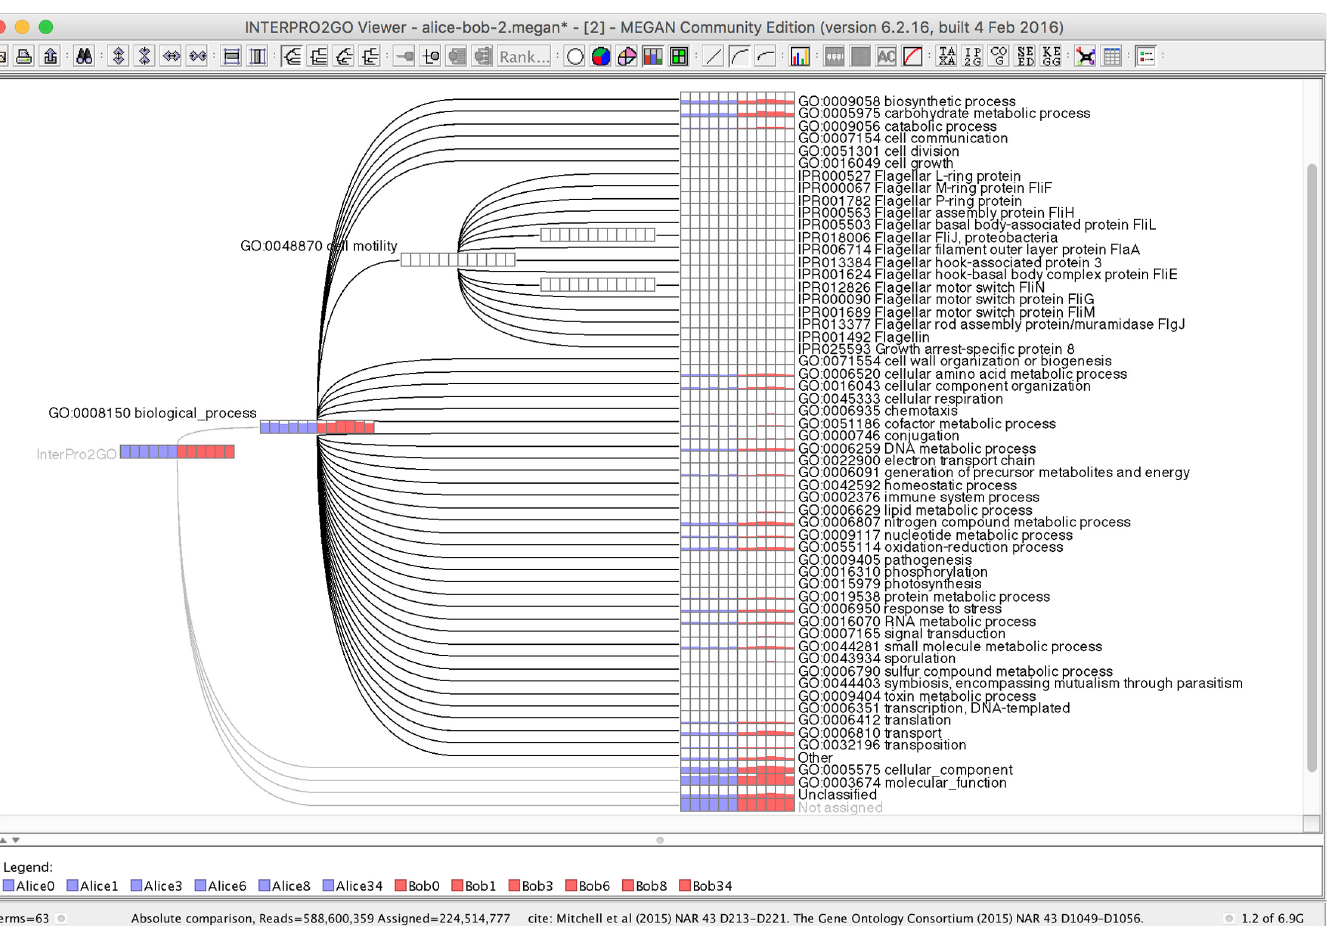
Fig 2. The new InterPro2Go viewer. High-level nodes represent the metagenomic GO-slim [13], whereas low-level nodes are based on InterPro [5]. Here we have uncollapsed the GO “ biological process ” domain node to show the second tier nodes attached below it. Each node is labeled by a bar chart representing the number of reads assigned to the node, or below it, for 12 different human stool samples [16]. In this example, 27.5% of 816 million reads are assigned to an InterPro family by MEGAN CE.